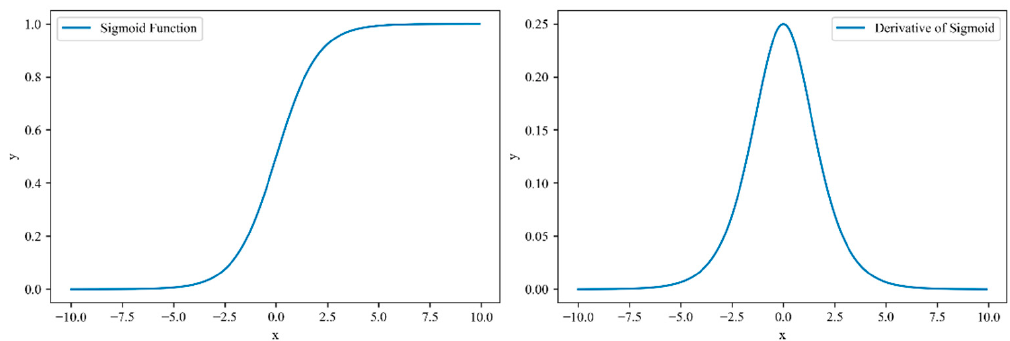
Figure 2. The process of the abnormal data cleaning method for wind turbines based on constrained curve fitting.